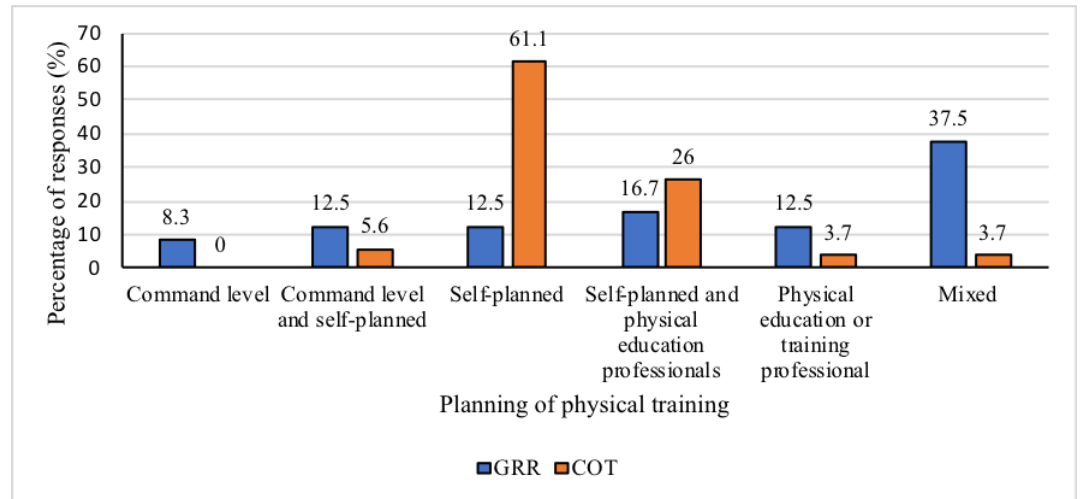
Figure 3. Percentage of responses on the planning of physical training of operators of special operations police units, selected from the command/management level, command/management and self-planned, self-planned, self-planned and by physical education professionals, physical education or training professional, mixed way (command/management level, self-planned, and by a physical education professional). COT = Tactical Operations Command; GRR = Rapid Response Group.